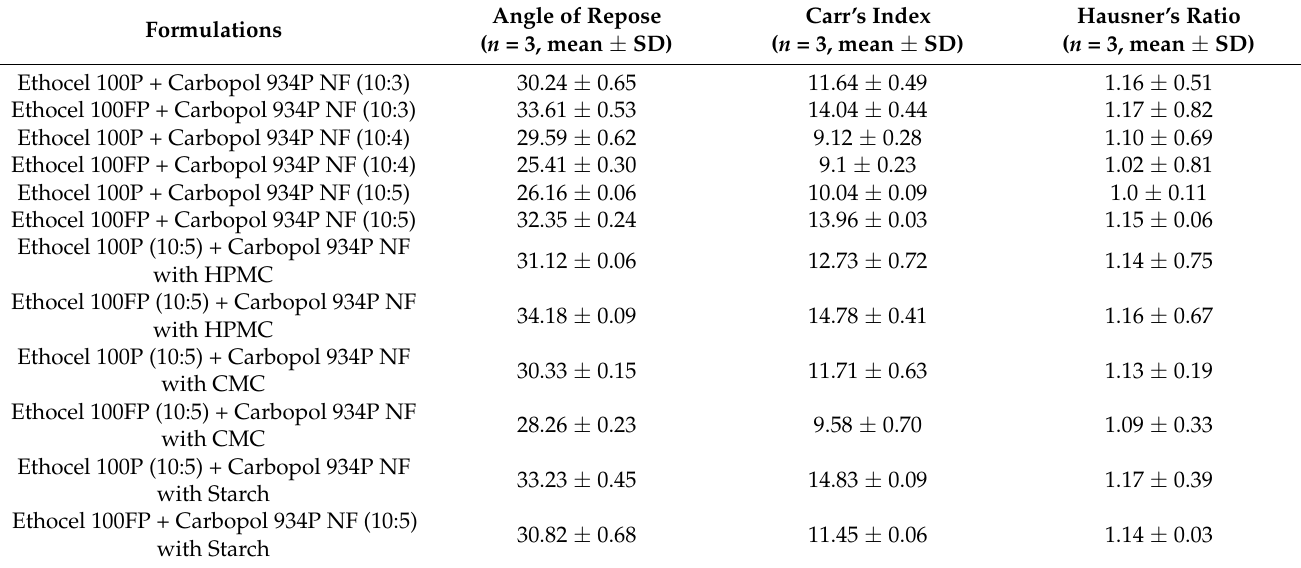
Table 2. Flow properties of formulation